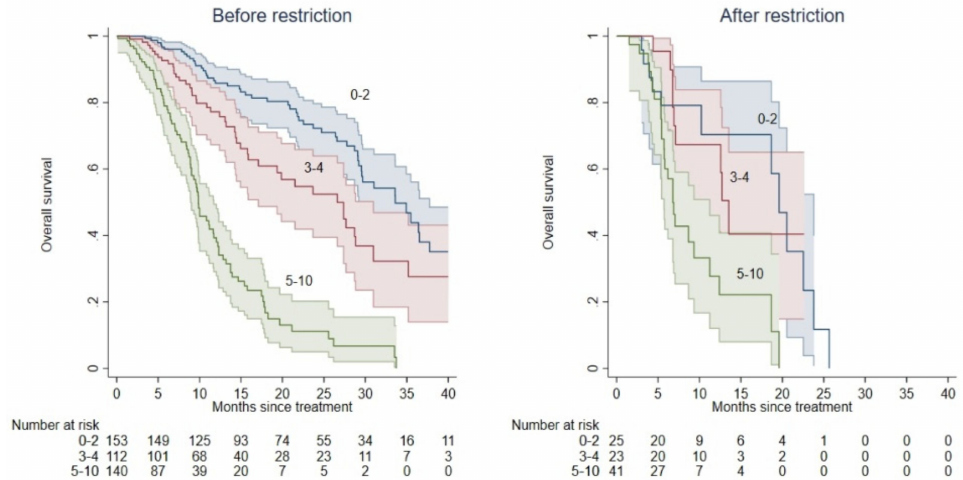
Figure 2. Kaplan-Meier OS curves according to the BIO-Ra risk classes before and after the EMA restriction of the use of Ra-223. OS prediction according to the BIO-Ra score, categorizing patients into three prognostic groups before ( left Panel ) and after ( right Panel ) the EMA restriction of the use of Ra-223. BIO-Ra scores 0–2, 3–4, and 5–10 corresponding to low-, intermediate-, and high-risk classes are represented as blue, red, and green colours,